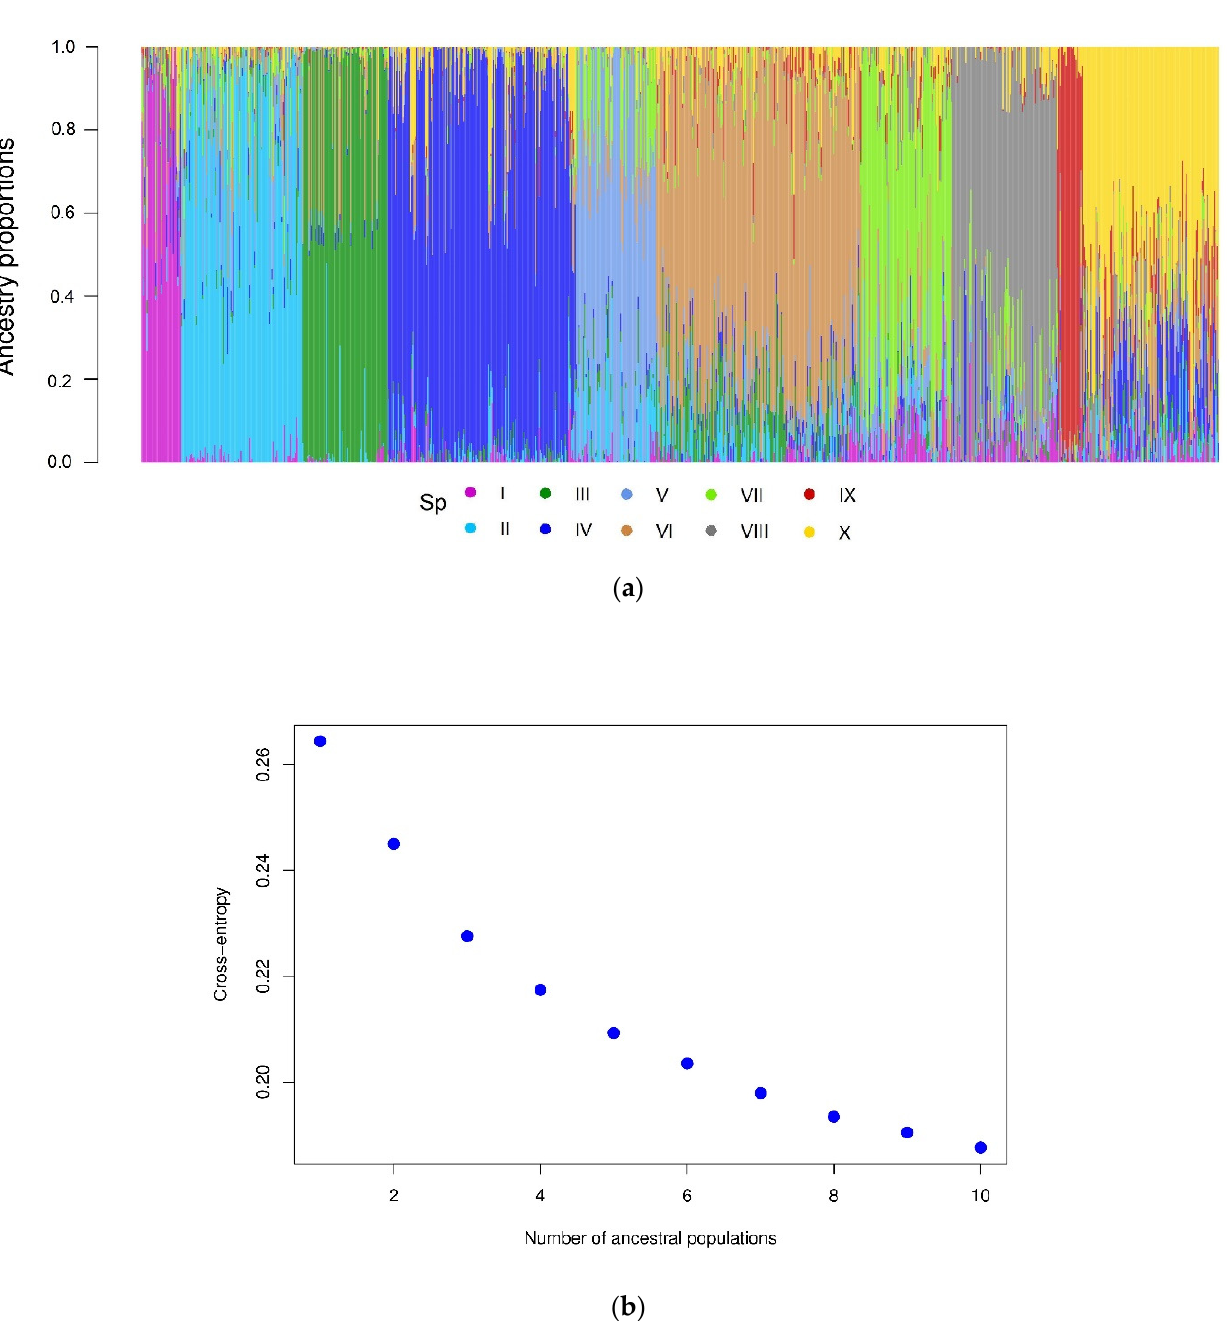
Figure 2. ( a ) Grouping of subpopulations (K= 10); each collection is represented by a thin vertical line, divided into colored segments representing the estimated probabilities of belonging (Q) to each subpopulation. ( b ) Ancestry coefficients estimated by LEA.